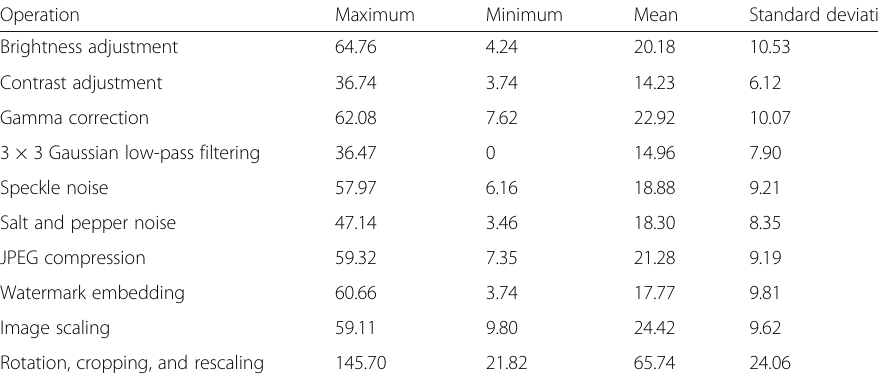
Table 2 Detailed statistical results of different operations